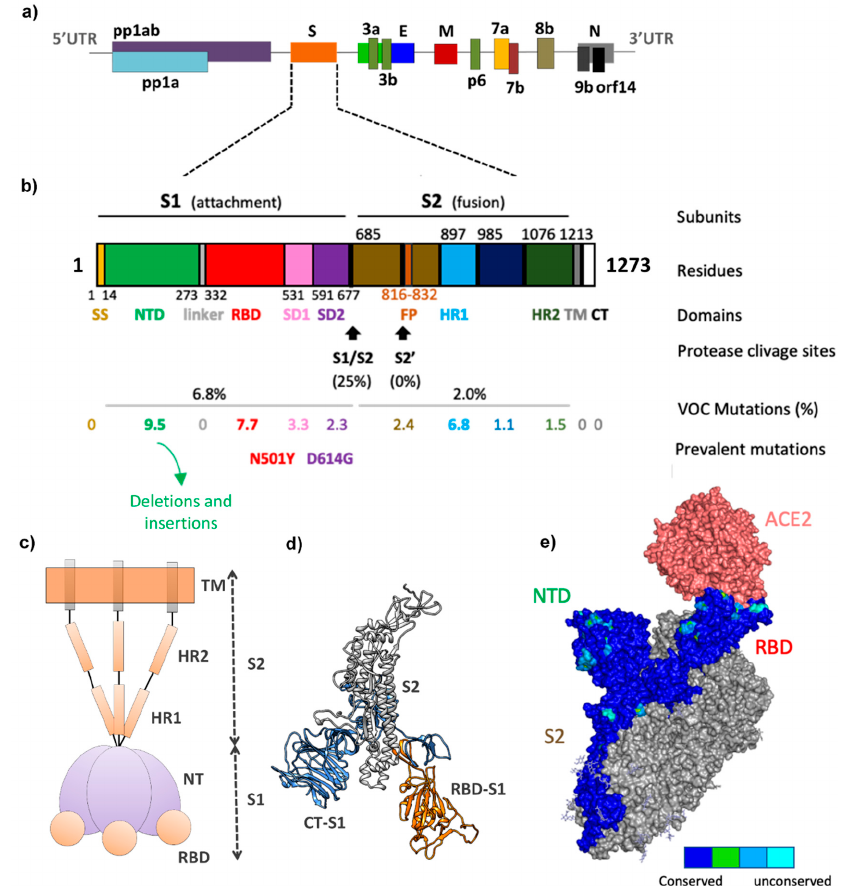
Figure 1. Structural features of SARS-CoV-2 Spike protein. ( a ) Genomic organization of SARS-CoV-2 based on the sequence of locus NC_045512.2 in the NCBI. ( b ) Domains in the Spike sequence. The SARS-CoV-2 Spike protein has two main subunits: S1 and S2, the first is related to the binding to the host cellular receptor, whereas the last allows the fusion of the viral and cellular membranes. During the infection process, the Spike protein is processed by a human serine protease, TMPRSS2, at the S1/S2 and the S2’sites to activate virus entry [10–13]. The total length of SARS-CoV-2 Spike is ~1273 amino acids and consists of a signal peptide (SP) located at the N-terminus followed by the S1 subunit composed of a N-terminal domain (NTD), a receptor binding domain (RBD) and SD1 and SD2 domains. The S2 subunit is composed of the fusion peptide (FP), the heptapeptide repeat sequences 1 (HR1) and 2 (HR2), a transmembrane domain (TM) and a cytoplasm domain (CT) [5,6]. The percentage of mutations in each domain of the Spike protein in relation to the Alpha, Beta,